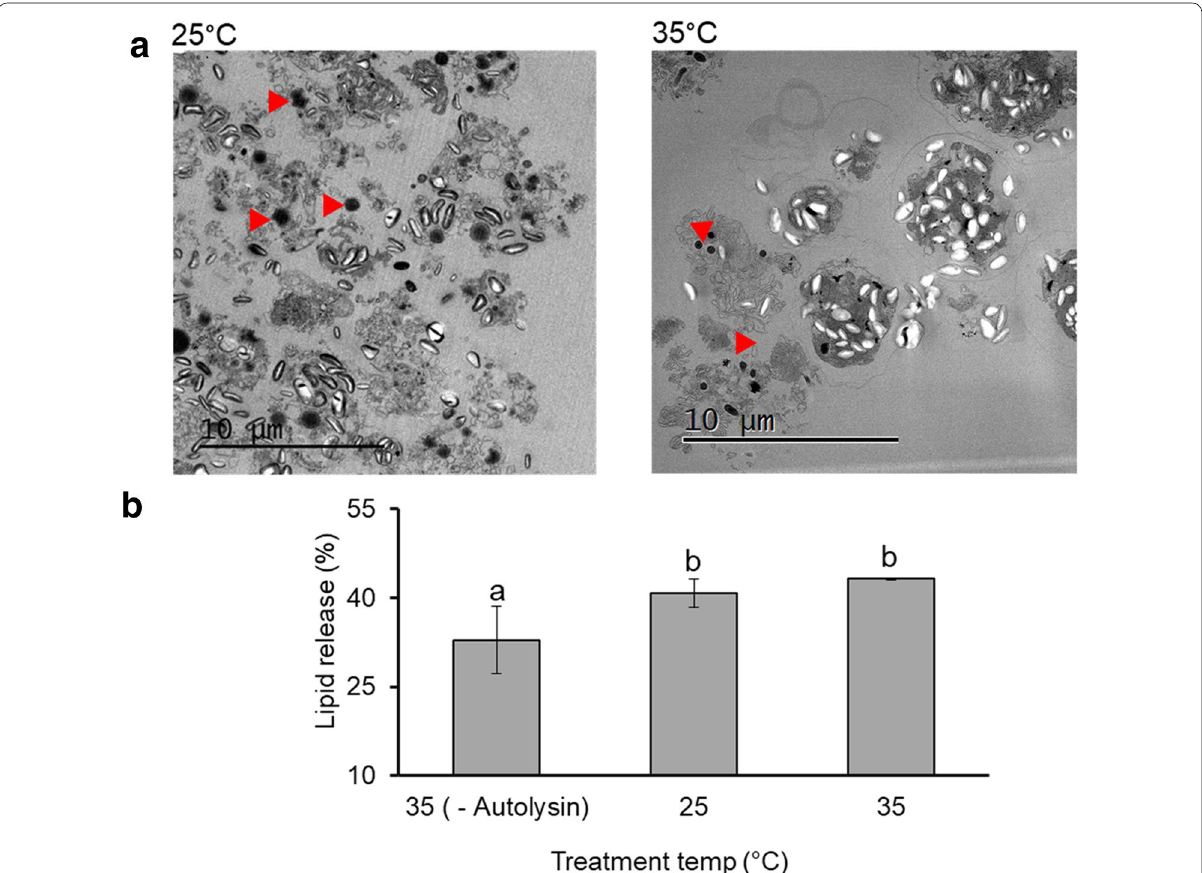
Fig. 3 a TEM images of solid fractions (pellets) after centrifugation of autolysin‑treated biomass at 25°C (left) and 35°C (right). b Percent lipid released (to the supernatants) after centrifugation of autolysin‑treated biomass or control (biomass incubated under same conditions but without autolysin) at 25°C or 35°C. Percentages determined by a modified Bligh and Dyer extraction method. Significant differences were found using a p value of